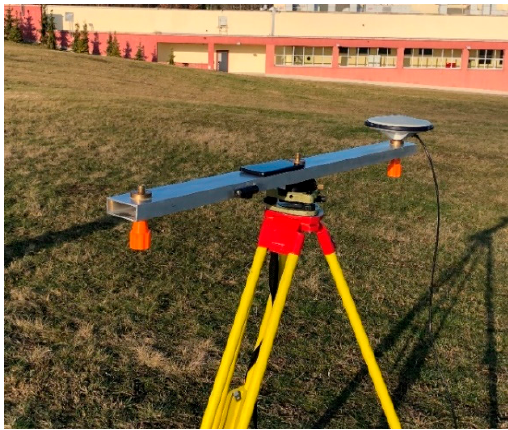
Figure 5. Third test setup. Huawei P30 Pro mounted in a horizontal position.